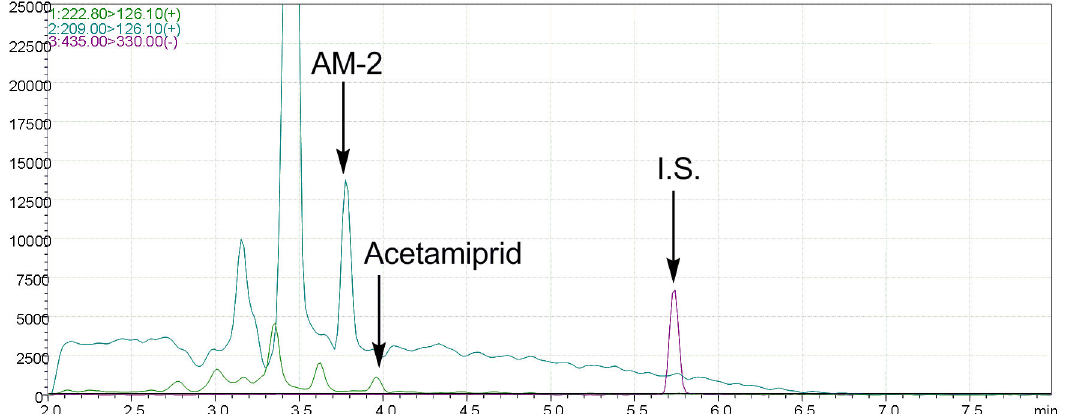
Figure 4. LC/MS/MS of the extract of urine of one case (#1) containing acetamiprid (green), N -desmethyl-acetamiprid (AM-2) (blue) and internal standard (I.S.) (red).